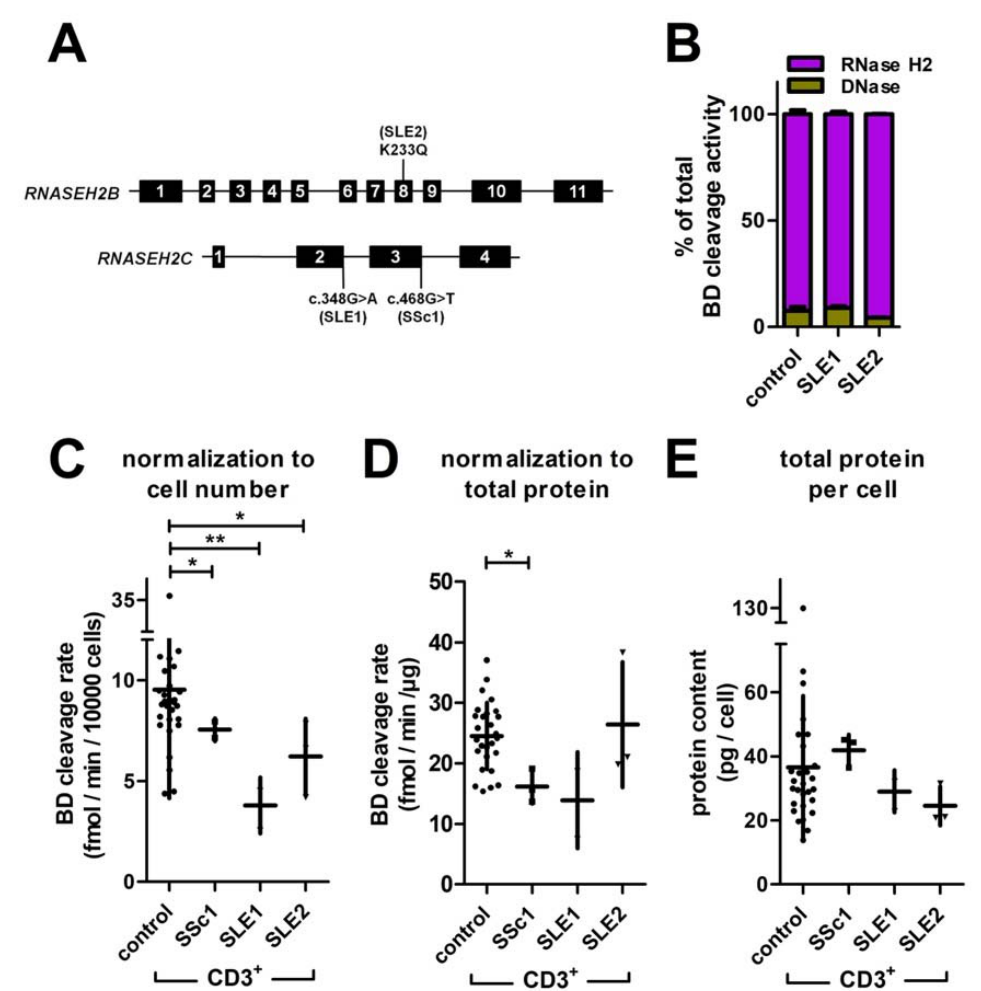
Figure 7. RNase H2 activity in T cells from SSc1, SLE1 and SLE2; ( A ) Mutation K233Q (SLE2) is located in exon 8 of RNASEH2B, while c.348G>A (SLE1) and c.468G>T (SSc1) are RNASEH2C splice site mutations at the end of exon 2 and 3, respectively, resulting in sterile transcripts [25]; ( B ) Rnase H2 activity accounted for 93% of total substrate BD cleavage activity in T cell lysates. Dnase activity was below the LOQ in all lysates. No differences were observed in patients and controls; mean ± SD is shown for five individuals of the control group (blood of each individual was sampled at two different time points in Ficoll ® ‐ gradient duplicates), two blood samples of SLE1 (Ficoll ® ‐ gradient duplicates) or three blood samples of SLE2 (Ficoll ® ‐ gradient duplicates); ( C – E ) total BD cleavage activity normalized to cell number ( C ) or to total cellular protein ( D ) and total cellular protein content ( E ) of T cells from SSc1, SLE1 and SLE2 compared to T cells from healthy controls (with unknown RNASEH2 genotype, n = 24) Activity was measured using 3 μ g of cellular protein (approximately 30 ′ 000–50 ′ 000 cells); mean ± SD is shown, and individual data points indicate single measurements of controls (a single Ficoll ® ‐ gradient and pipetting replicate each), three Ficoll ® ‐ gradient replicates of SSc1 (sampled at the same time), or the mean of duplicate Ficoll ® ‐ gradient replicates from each blood sampling (SLE1 and SLE2); significance was tested via unpaired two ‐ tailed t ‐ test with Welch’s correction: ** p < 0.01, * p < 0.5.